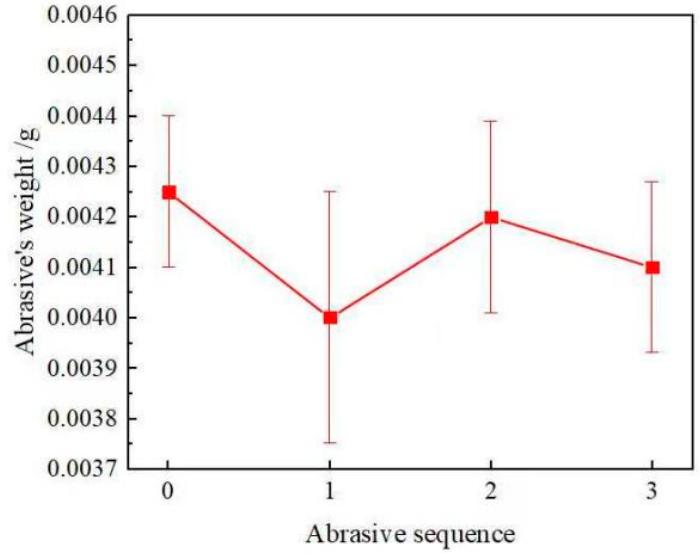
Figure 15. Changes in the quality of the abrasive particles before and after wear.